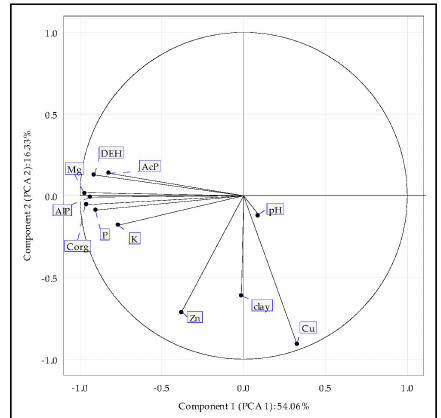
Figure 6. Configuration of variables in the system of the first two axes PC1 and PC2 of principal components in the control soil in